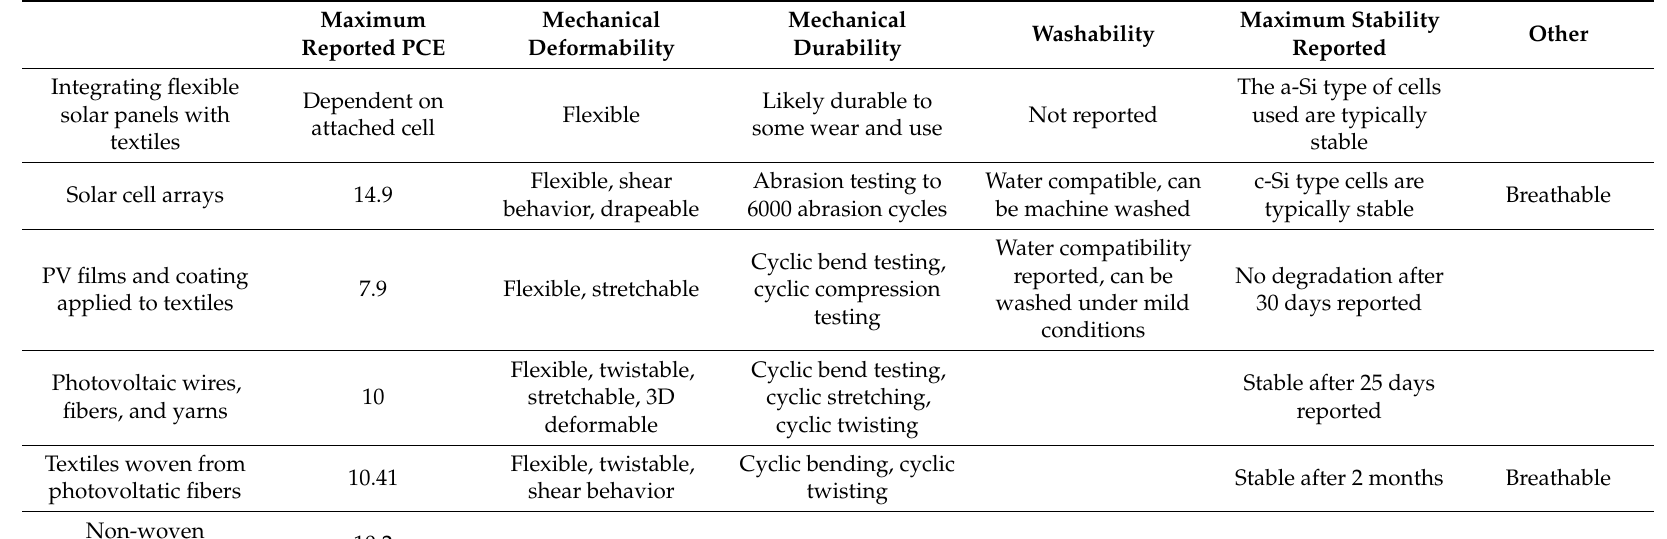
Table 5. Summary of key details reported on solar E-textiles. Not all devices will have these properties or PCEs. Please note that PCE (%) are the values given and do not account for any di ff erences in how the PCE may have been calculated between